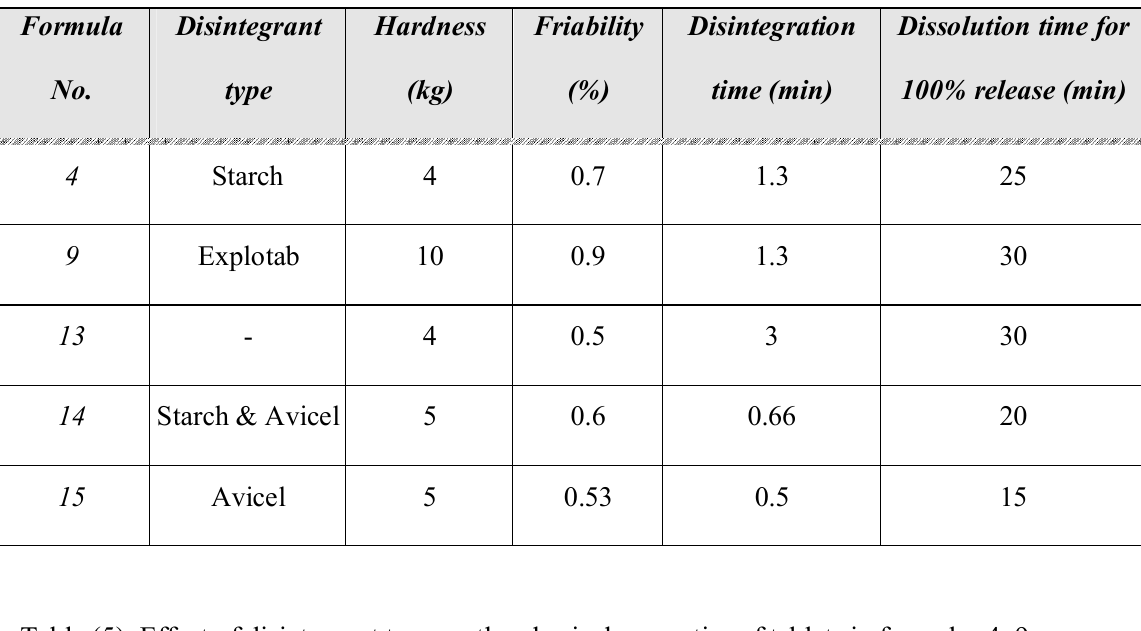
Table (5): Effect of disintegrant type on the physical properties of tablets in formulas 4, 9, 14, and 15 Formula